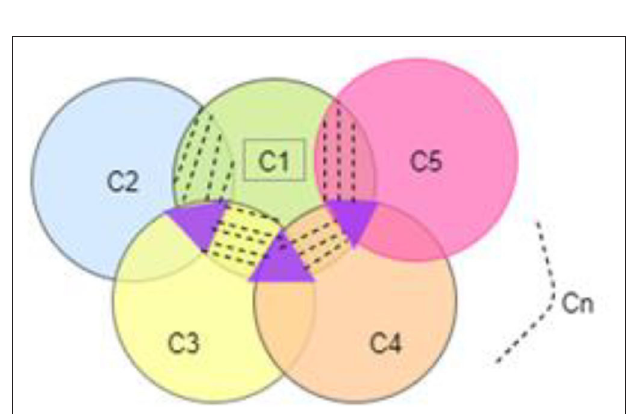
FIGURE 4 | Cluster representation of extracted